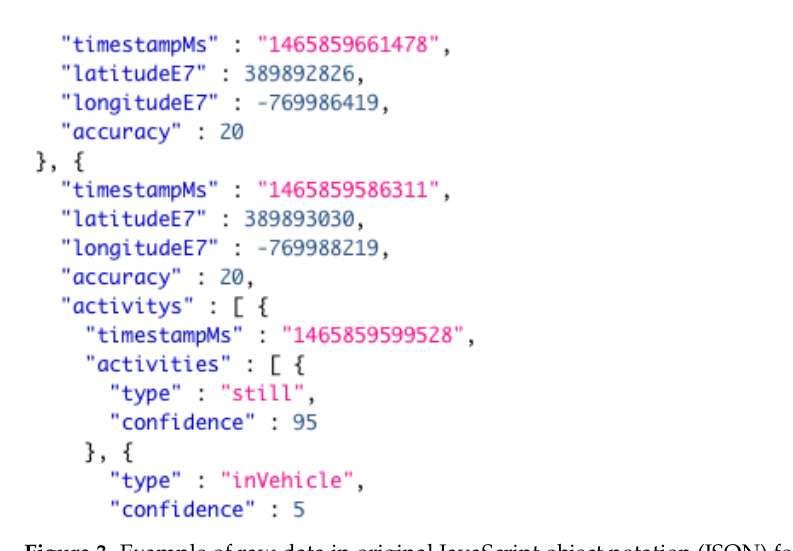
Figure 4. Example of parsed data in comma separated values (CSV)